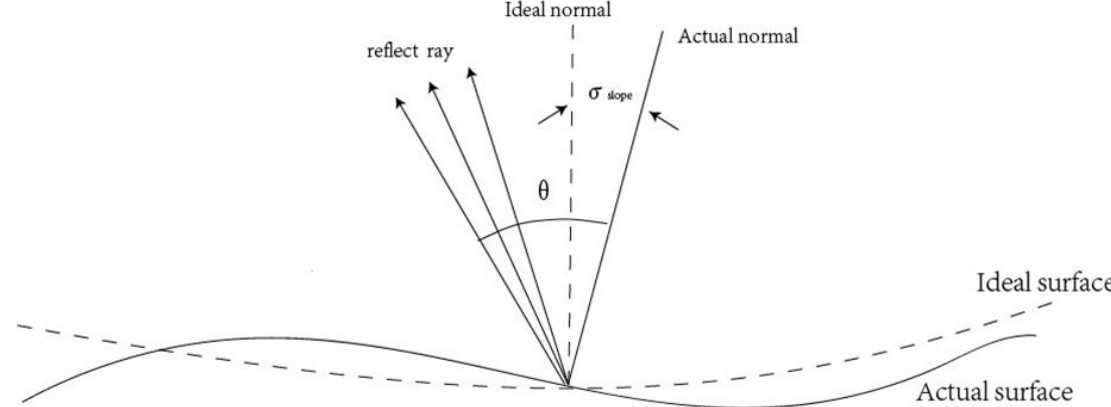
Figure 1. Slope error σ slope and reflection cone θ .